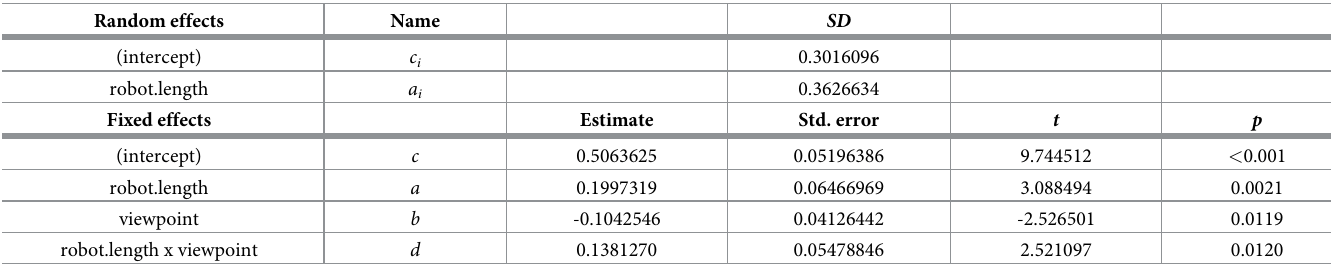
Table 3. Results of the linear mixed model (5) for predicted back-off